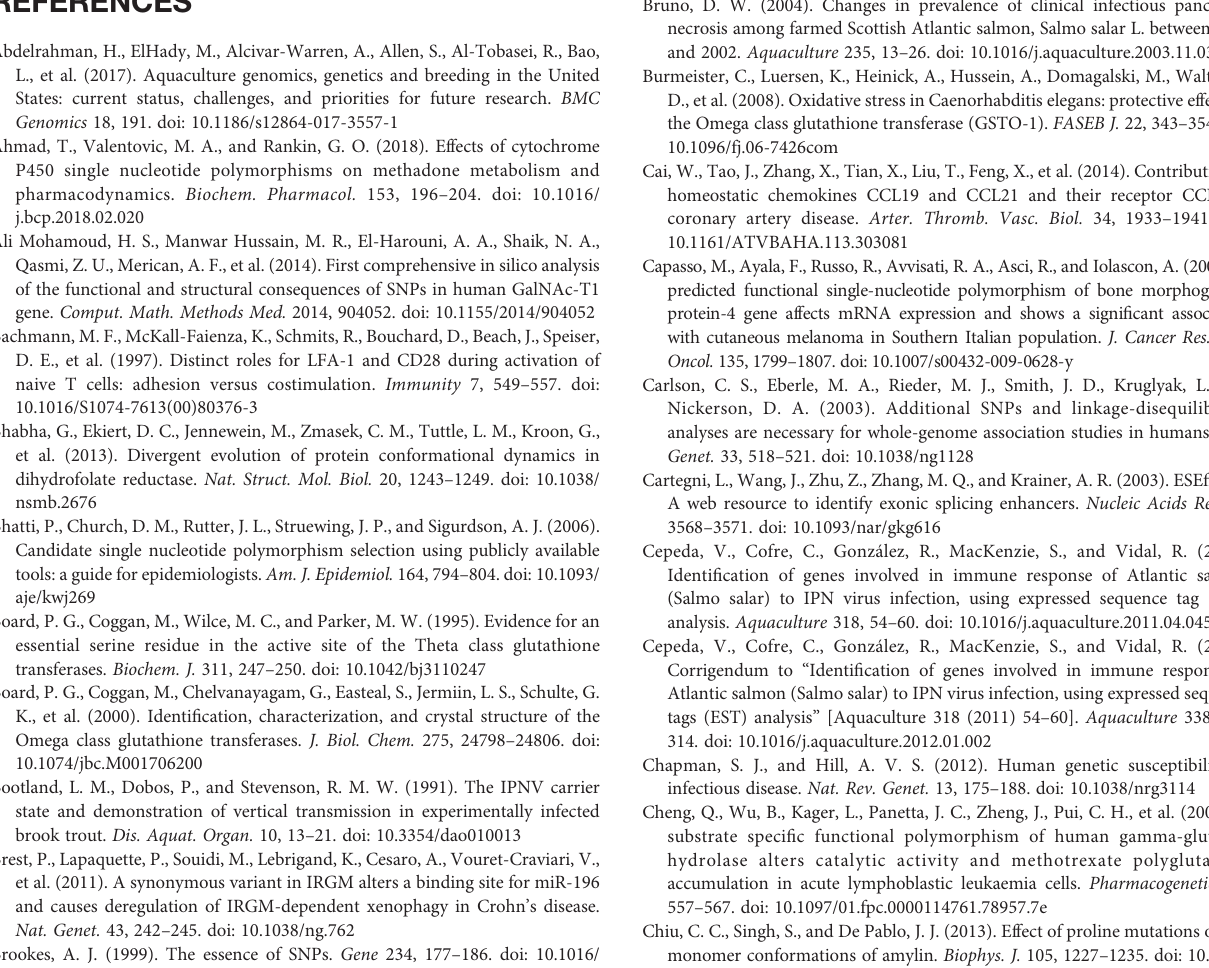
(hHSP70) structure. (B) Predicted tridimensional S. salar HSP70 (sHSP70) structure. (C) hHSP70 and sHSP70 overlay. (D) Ramachandran plot for the predicted sHSP70 structure. The amino acid distribution into most favored regions (A,B,L), additional allowed regions (a,b,l,p), generously allowed regions (~a,~b,~l, ~p) and disallowed regions (GLN83 and ALA540) is represented. FIGURE S4 | Homology modeling for predicted S. salar MHC class I based on tridimensional H. sapiens MHC class I structure. (A) Tridimensional H. sapiens MHC class I (hMHC class I) structure. (B) Predicted tridimensional S. salar MHC class I (sMHC class I) structure. (C) hMHC class I and sMHC class I overlay. (D) Ramachandran plot for the predicted sMHC class I structure. The amino acid distribution into most favored regions (A,B,L), additional allowed regions (a,b,l, p), generously allowed regions (~a,~b,~l,~p) and disallowed regions (ASP39 and ILE40) is represented. FIGURE S5 | Molecular dynamics simulation for the wild-type GSTO-1 (A) and the variants S26G (B) , S119P (C) , and T214P (D) . The root mean square deviation (RMSD) of the C a atoms on a time windows explored of 100 ns is shown for each replicate. FIGURE S6 | Root mean square fl uctuation (RMSF) pro fi les for each mutant analyzed (S26G; S119P; T214P) compared to the GSTO-1